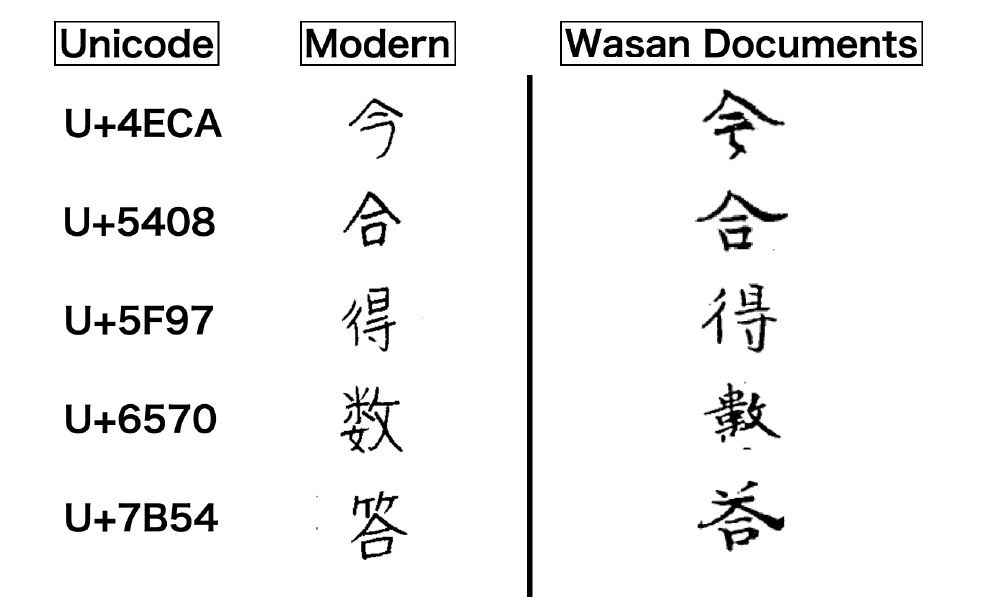
Figure 3. Some kanji characters have changed the way they are written between the Edo period and modern times. The “ima” 今 kanji character (top) is of particular interest for our study. Thus, we needed datasets containing the largest possible number of example of